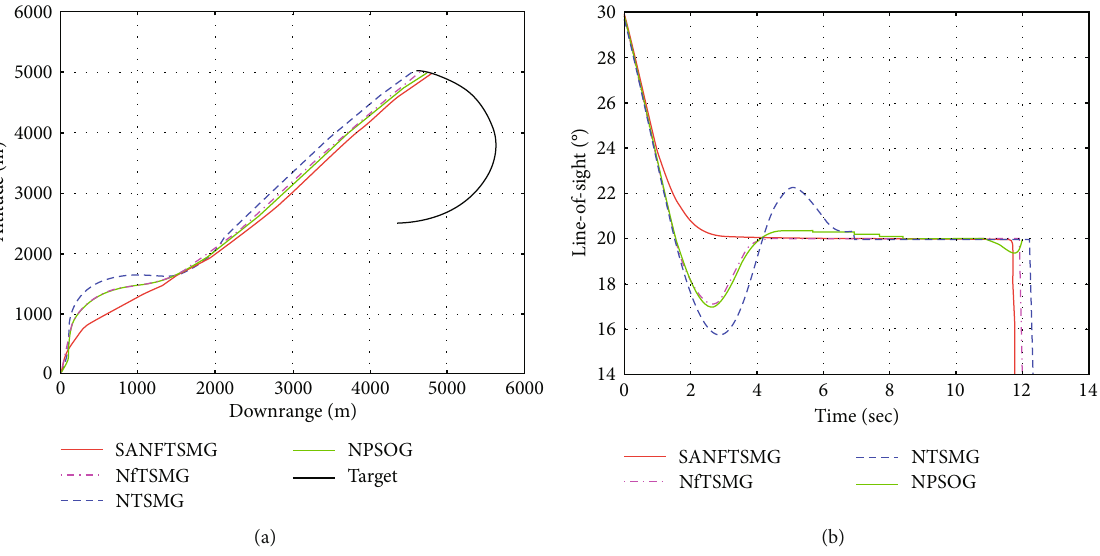
Figure 8: Simulation results of intercepting step-maneuvering targets.